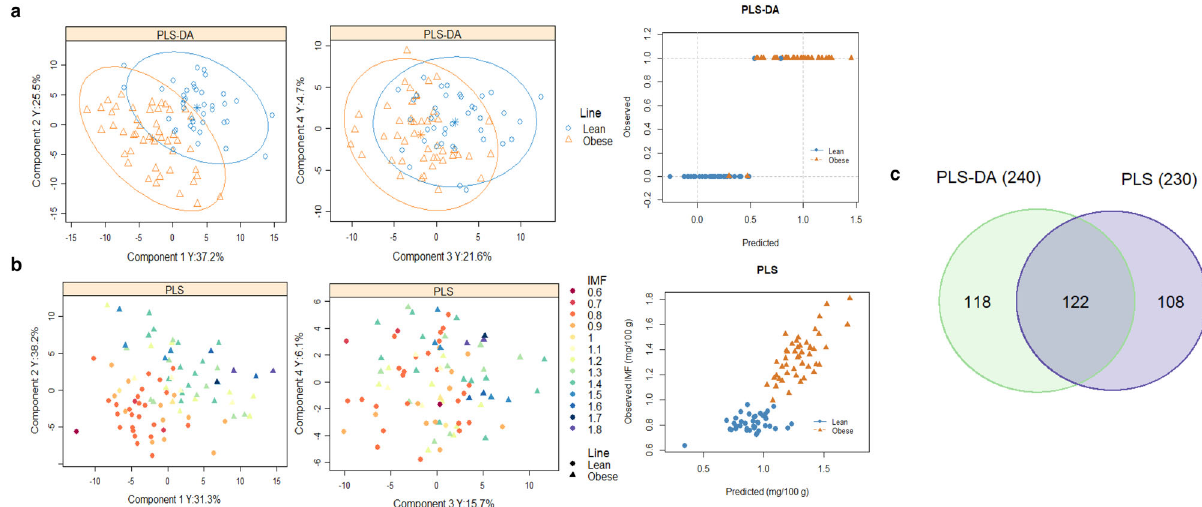
Fig. 1 Comprehensive identi fi cation of cecal core microbial gene (MG) additive log-ratio ( alr ) transformed abundances evidencing a correlated response to selection for intramuscular fat content. Individual plots ( n = 89) and observed vs. cross-validation predicted values (with seven validation groups) obtained from a . Partial least squares discriminant analysis (PLS-DA) (each line is represented by a different color, contoured by 95% con fi dence ellipses) and b . Partial Least Squares (PLS) analysis (colored by increased intramuscular fat content, g/100 g of muscle (IMF)). The fi nal models were built based on 4 latent components in both cases and 240 or 230 MG alrs , respectively. PLS-DA model showed a misclassi fi cation rate of 0%, and a cross- validation misclassi fi cation rate of 5%. PLS model showed a goodness of fi t (R 2 ) of 91% and a goodness of prediction after cross-validation (Q 2 ) of 79%. c Venn diagram displays 122 MG alrs selected in both PLS-DA and PLS analysis, while 118 were selected exclusively in PLS-DA, and 108 exclusively in PLS